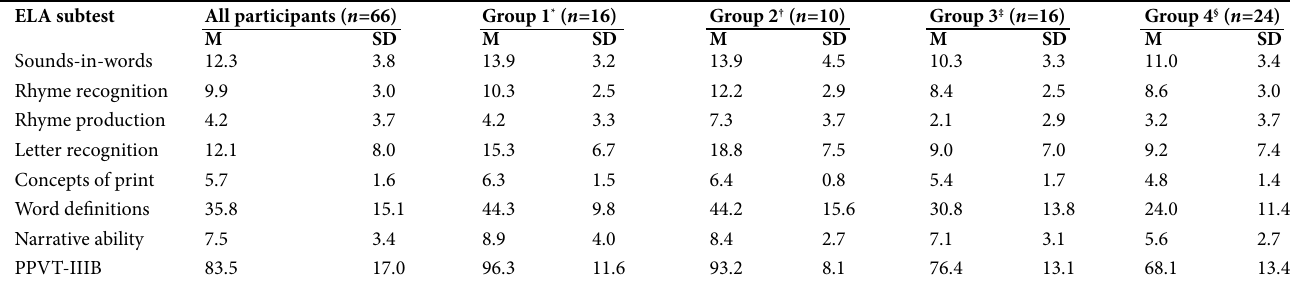
table iv. Mean scores (M) and standard deviations (SDs) upon entering grade 1, post